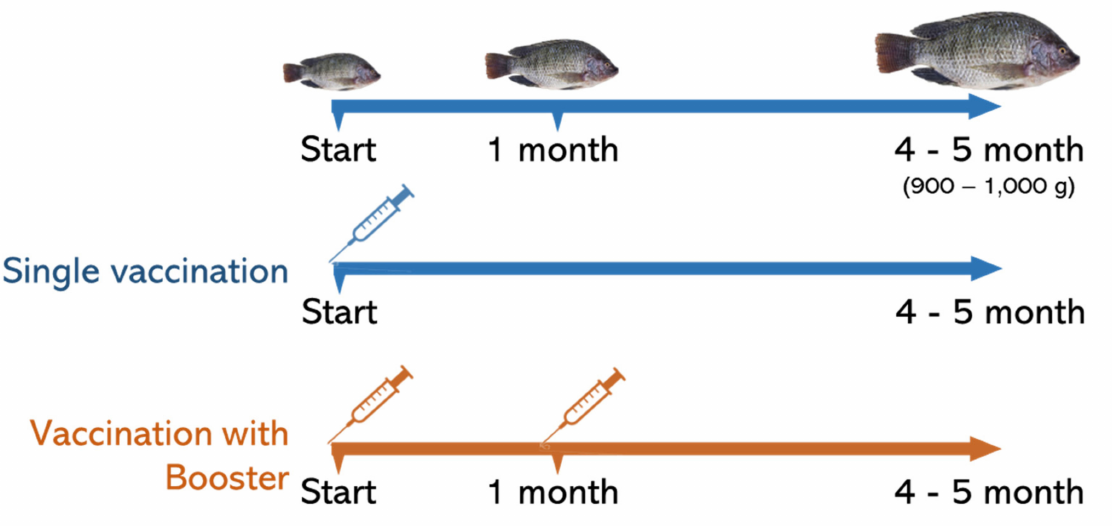
Figure 2. Schematic diagram of vaccination plan for evaluating bivalent streptococcal vaccine efficacy by single and booster